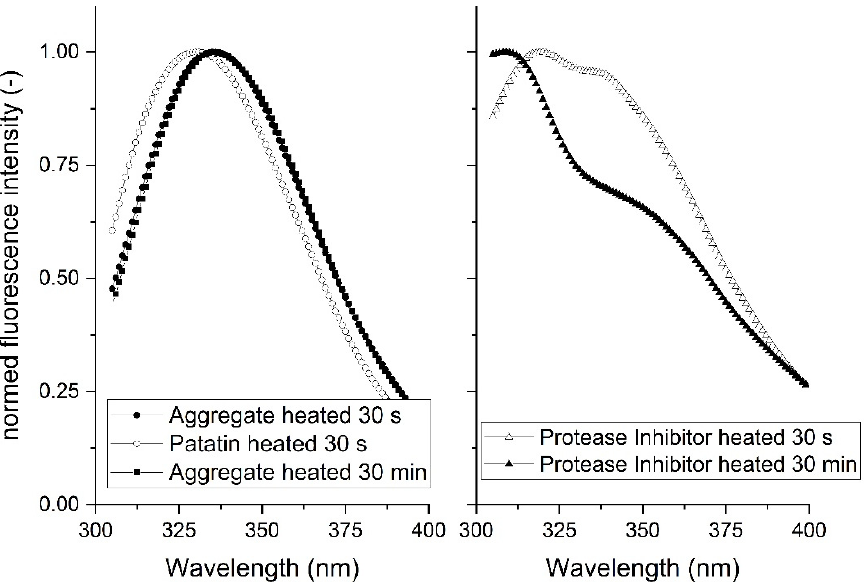
Figure 8. Fluorescence spectra of the patatin, aggregate (>670 kDa), and protease inhibitor fraction, determined by coupled SEC and FLD. Spectra were normed on the maximum detected emission value. Excitation of the sample was done at 280 nm.